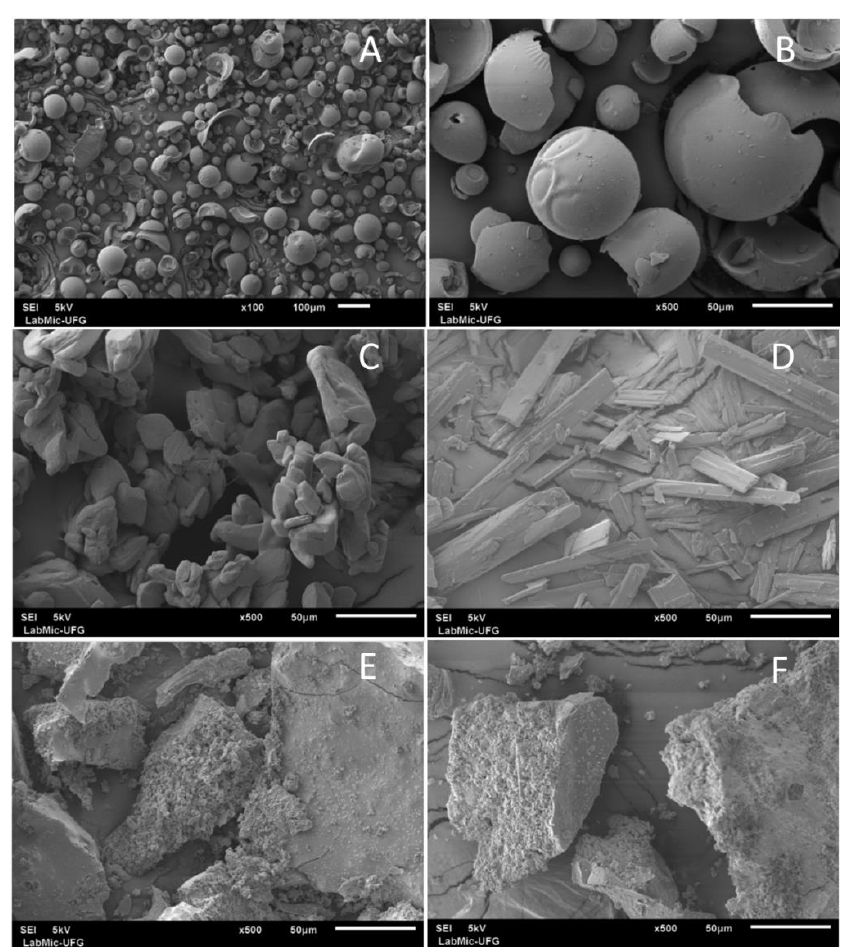
Figure 8. Scanning electron photomicrographs of ( A ) HP- β -CD; ( B ) HP- β -CD; ( C ) PSO; ( D ) 5-MOP; ( E ) PSO-HP- β -CD inclusion complex (1:1); ( F ) 5-MOP-HP- β -CD inclusion complex (1:1). 100× magnification ( A ) and 500× magnification ( B – F ).